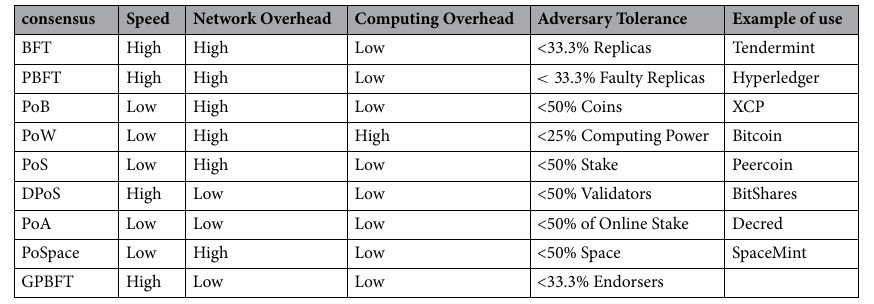
Table 1. Comparison between